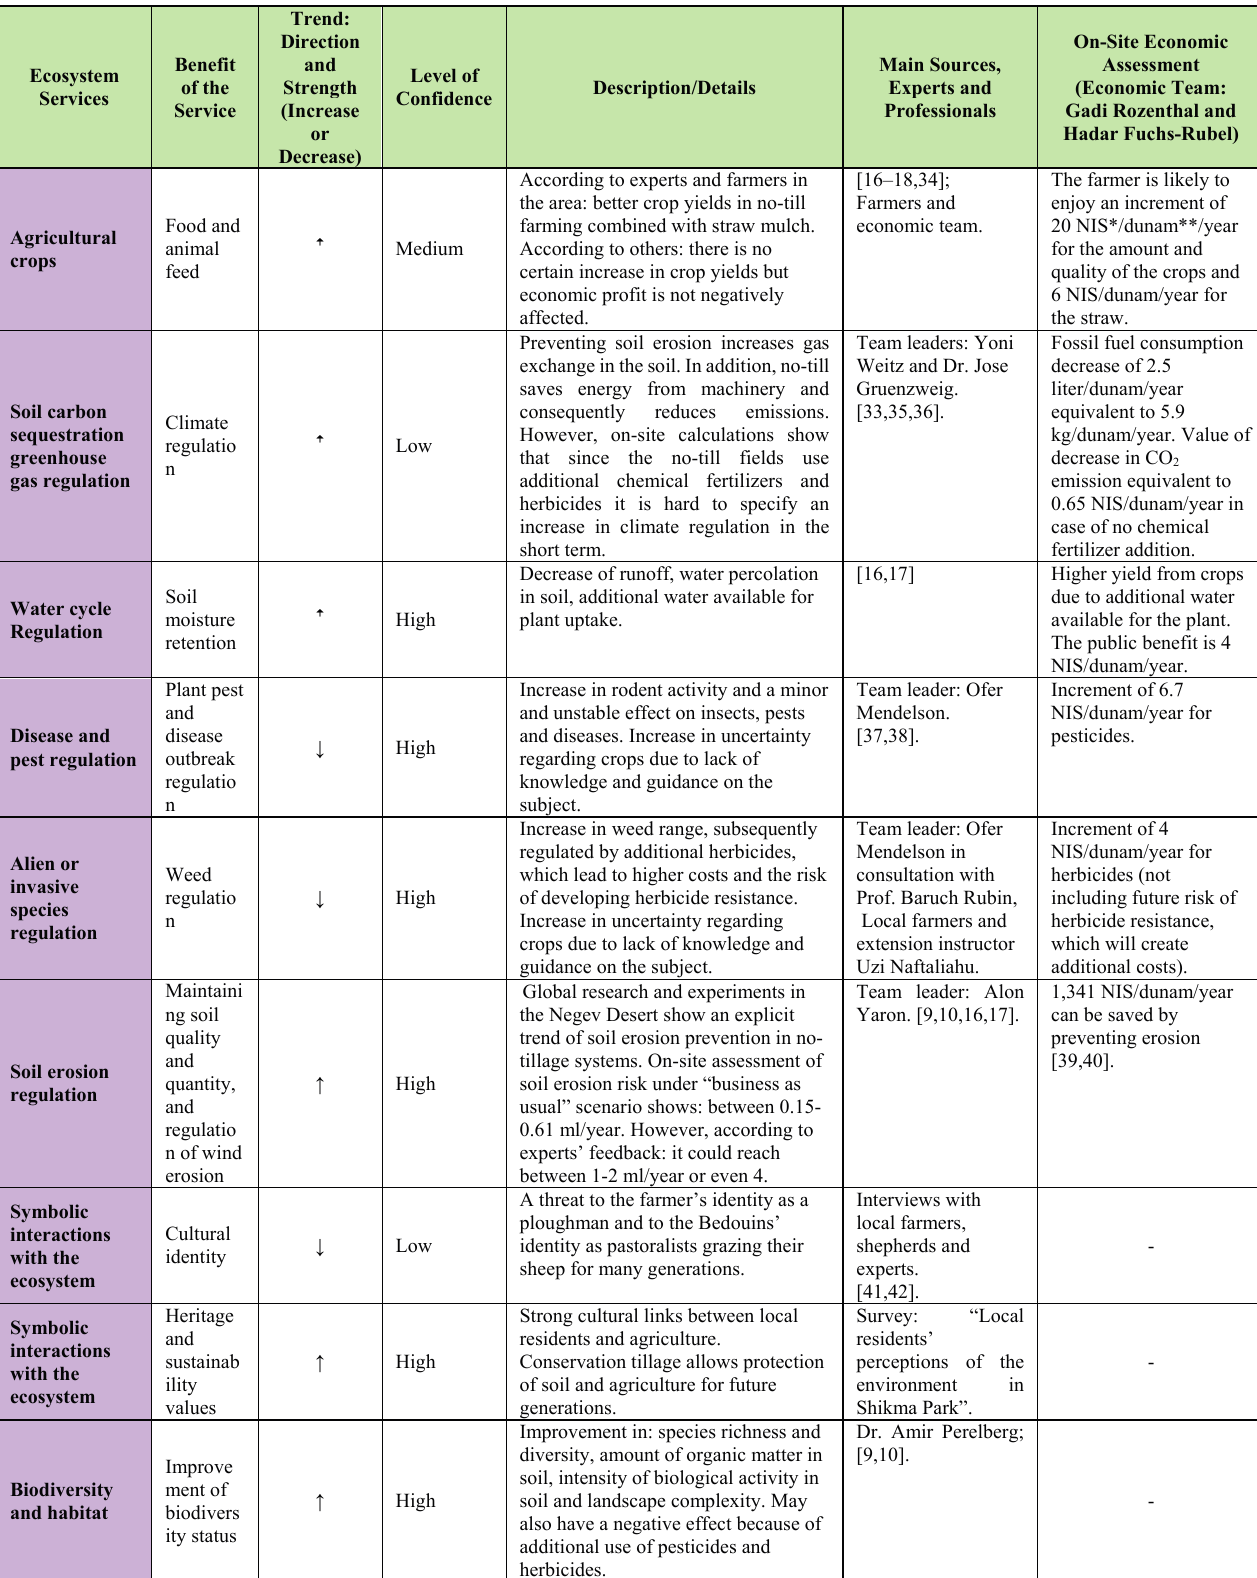
Table 2. The effect of the transition from minimum tillage to no-tillage on ecosystem services delivery based on experts’